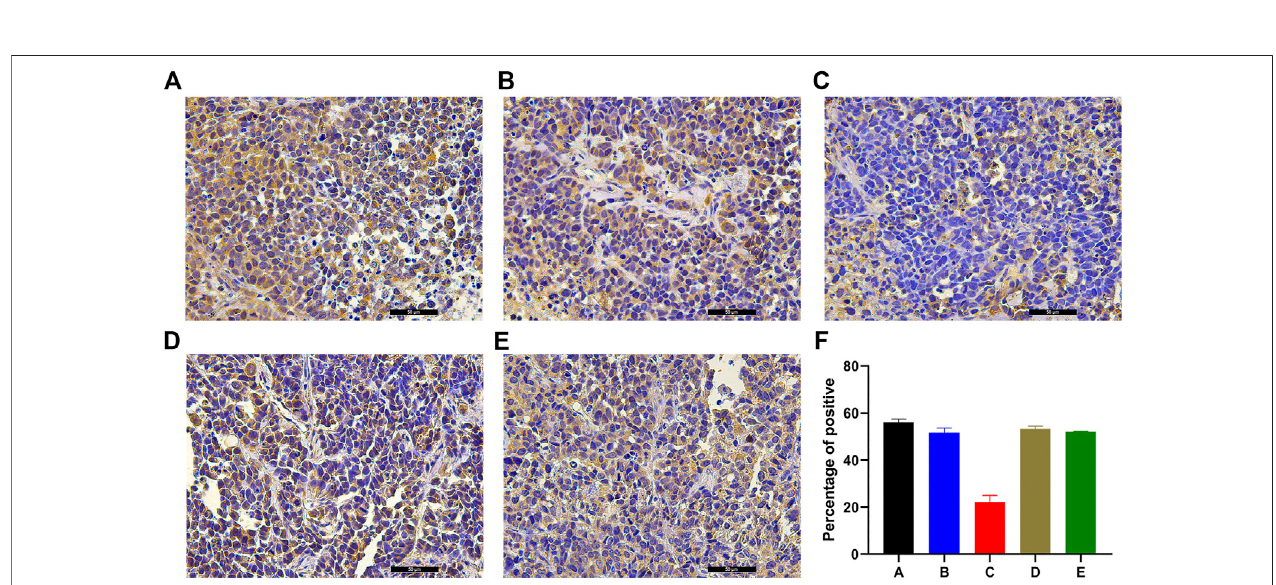
FIGURE 3 | Example of the variability of IHC staining within tumor samples. (A) Group A showed strong staining, indicating the HCC cells surrounded by NET-1 protein(brown). (B) TherewasalsoanamountofNET-1proteinsaroundthetumorcellsingroupB. (C) Therewaslittlebrownstainingaroundthetumor,whichindicated the NET-1 protein was signi fi cantly inhibited in group C. (D , E) There were also a large number of NET-1 proteins around tumor cells in group D and group E. (F) Quantitative IHC analysis of all groups, original magni fi cation, × 400, Scale bar, 50